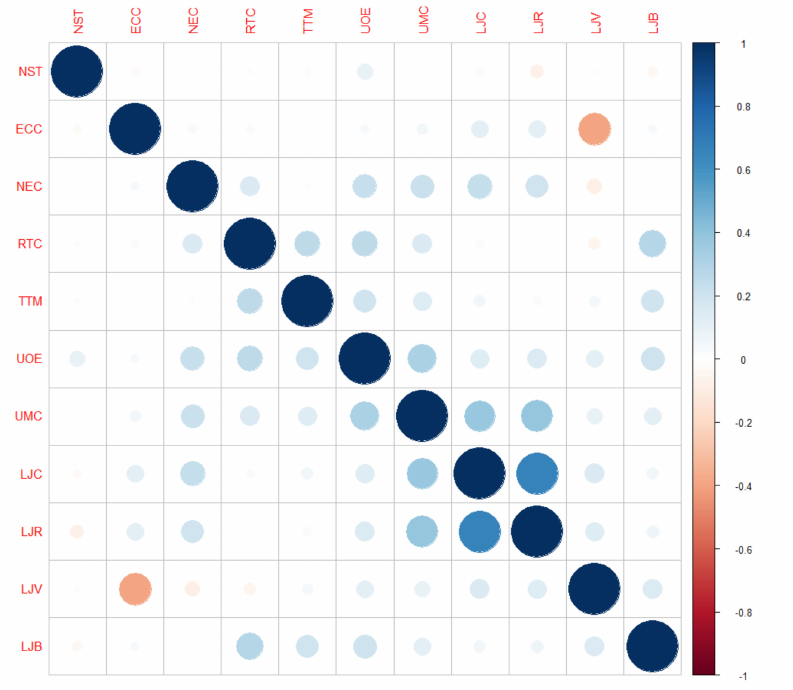
Figure 2. Correlations among the variables of the